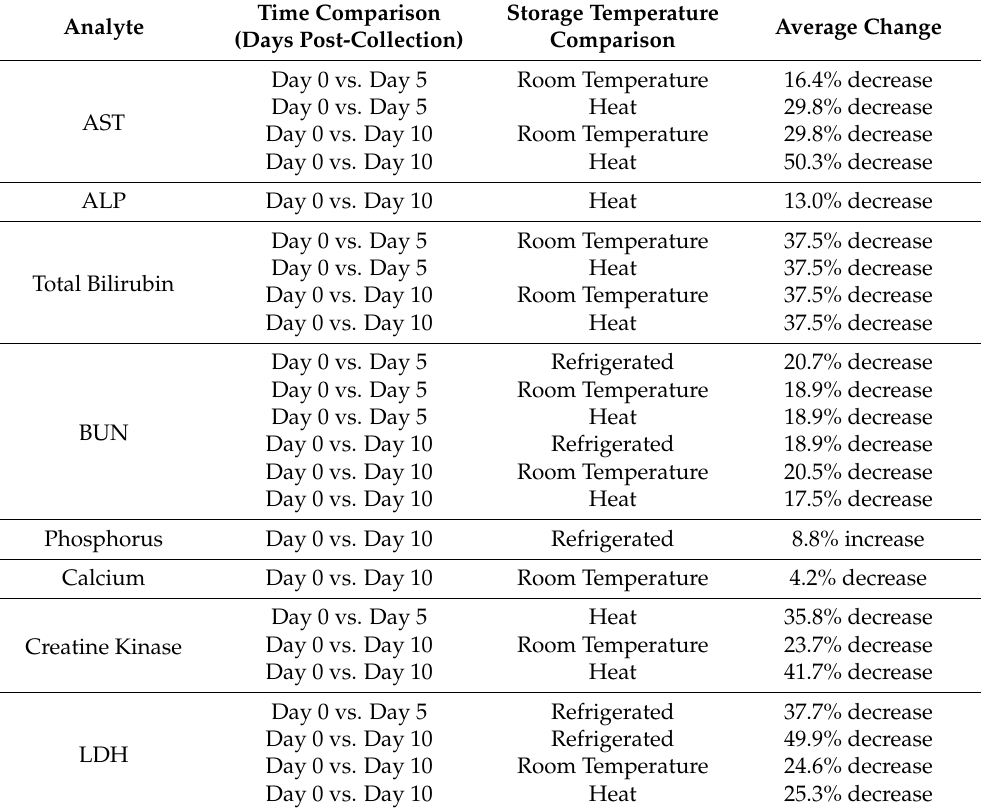
Table 2. Percent change of statistically significant biochemical analytes from African savanna ele- phants ( Loxodonta africana ) after serum storage under refrigeration (2.2 ◦ C), room temperature ~23 ◦ C), and heat (32.2 ◦ C) compared to Day 0